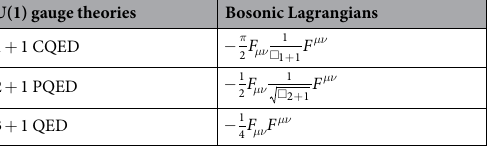
Table 1. The bosonic sector of the QED, PQED and CQED in the second column for ε 0 = c = 1. In lower dimensions, the Maxwell theory is replaced by suitable versions that contains pseudo-operators, i.e. ( ∂ 2 ) − η with η = 1 or 1/2, to adjust and preserve the dimensionality of the coupling constant [ e ] = 1. This means that QED, PQED and CQED are renormalizable